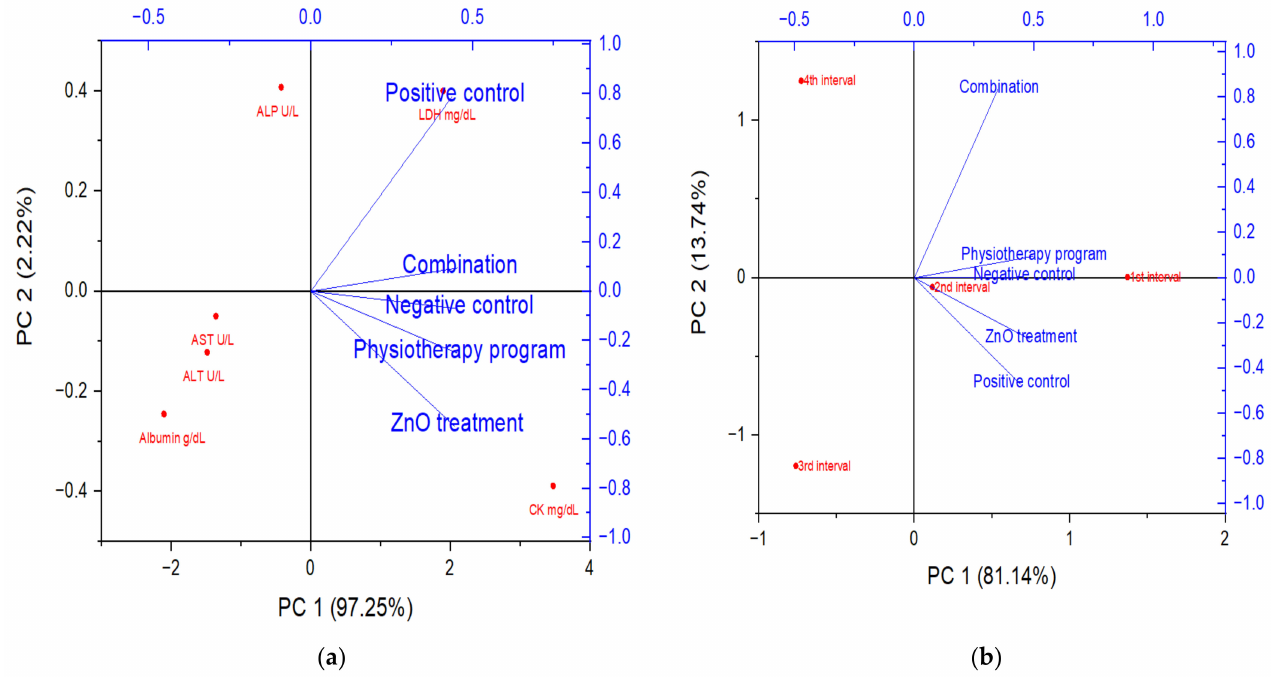
Figure 6. PCA of experimental rat groups where ( a ) the biochemical parameters and ( b ) the muscle